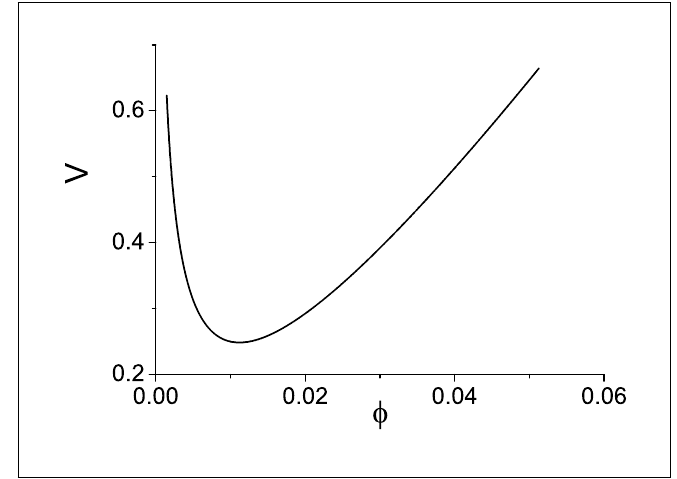
Figure3. Reconstructedscalarpotential V ( φ ) usingFigure2,underimposedbouncingscalefactorEquation(24) with B (cid:3) 1 , in units where 8 π G (cid:3) 1